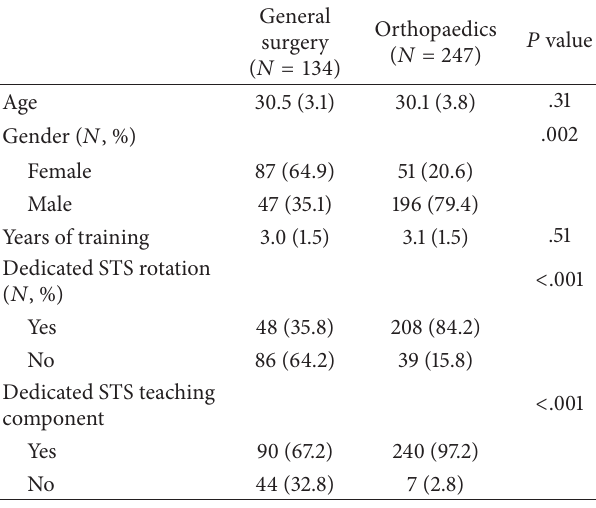
Table 1: Resident’s characteristics of both general surgery and orthopaedic surgery